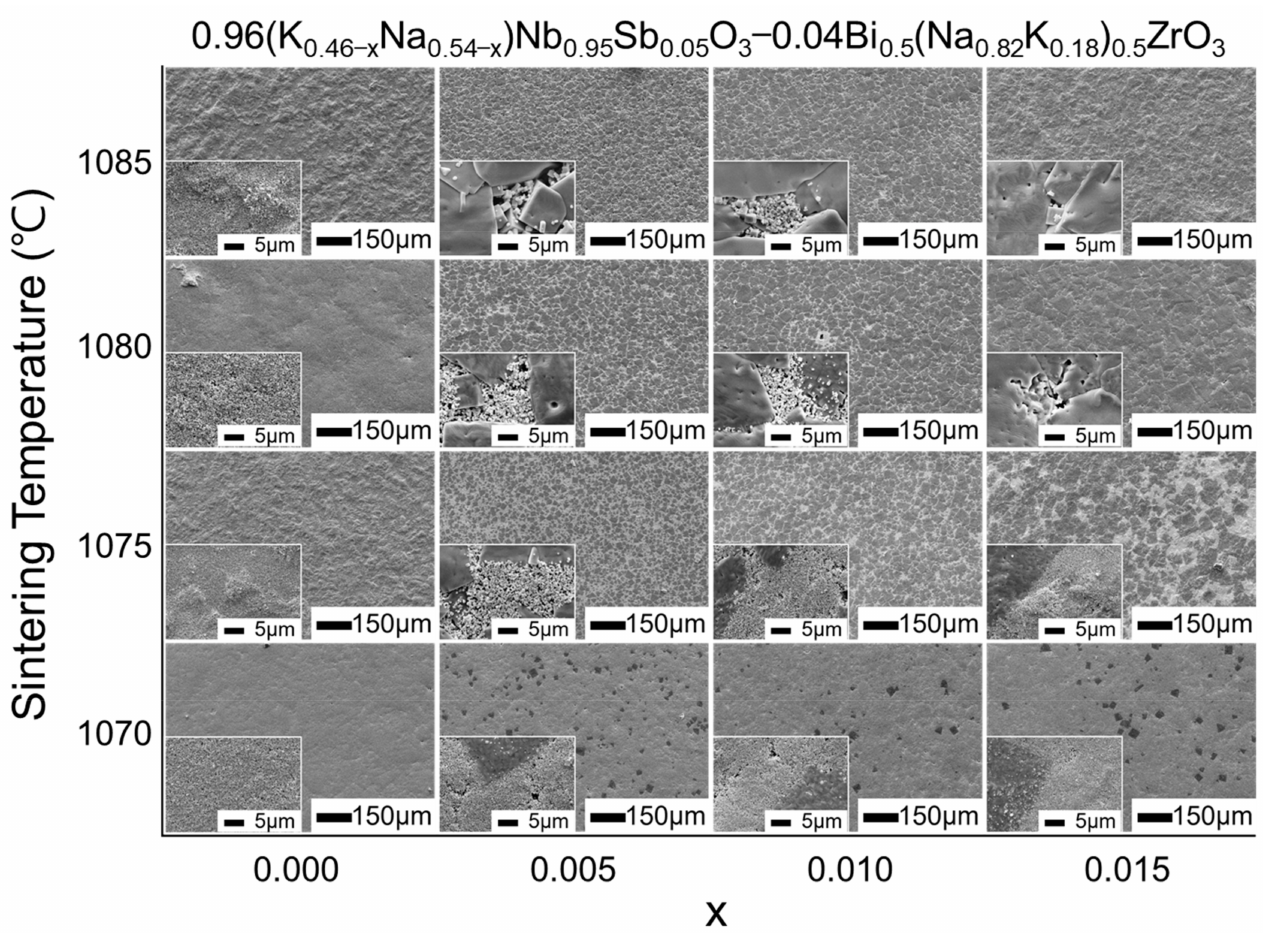
Figure 2. SEM images showing the microstructural evolution of 0.96(K 0.46 − x Na 0.54 − x )Nb 0.95 Sb 0.05 O 3 - 0.04Bi 0.5 (Na 0.82 K 0.18 ) 0.5 ZrO 3 ceramics sintered in the temperature range from 1070 to 1085 ◦ C for 4 h. Insets show magnified SEM images for each